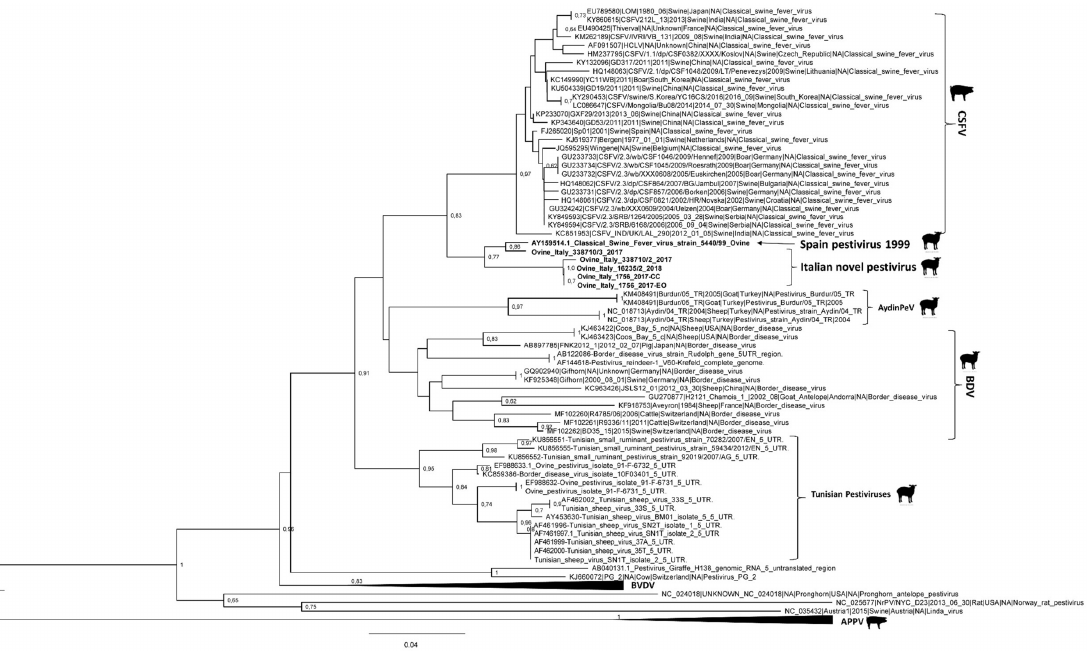
Figure 1. Maximum Likelihood phylogenetic tree constructed with five 5 (cid:48) -UTR sequences of the four pestiviruses identified in this study (Ovine / IT / 1756 / 2017-EO, Ovine / IT / 1756 / 2017-CC, Ovine / IT / 338710-2 / 2017, Ovine / IT / 338710-3 / 2017, and Ovine / IT / 16235-2 / 2018) and 100 pestivirus sequences retrieved from Genbank. Bootstrap values above 60% (1000 replicates) are shown. The novel Italian pestivirus strains and the Spanish strain isolated in 1999 are reported in